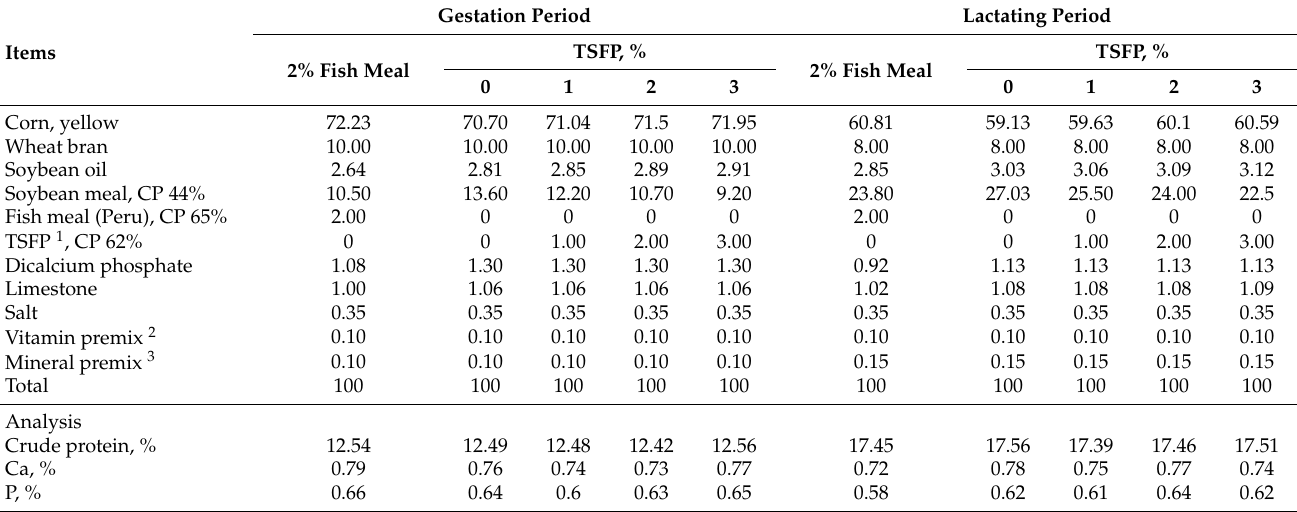
Table 1. Experimental feed